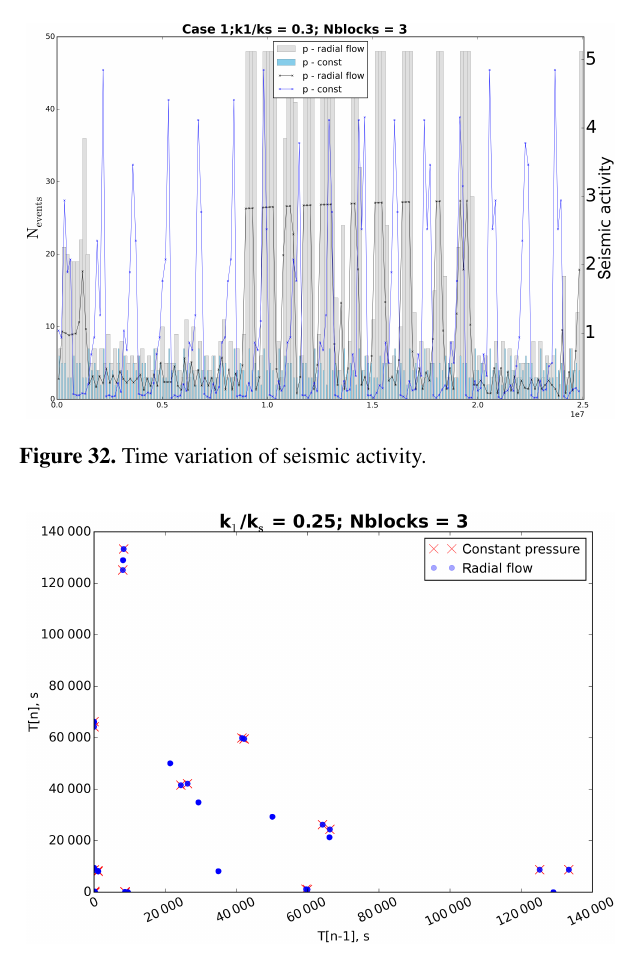
Figure 33. Iteration map of recurrence intervals of seismic events, T n denotes the time interval between the n th and ( n + 1)th events. The map includes events that occurred at time t ≥ 8 × 10 6 s.